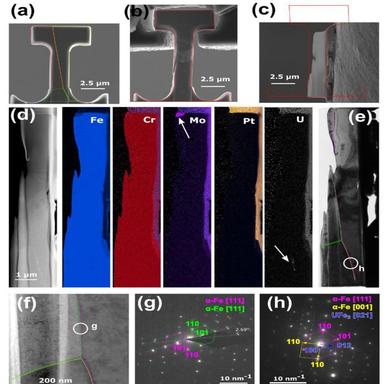
TEM characterization on the post-tested HT9_005 specimen. (a) A SEM image captured before testing with identified grains outlined; (b) a post-test SEM image; (c) a SEM image of the prepared TEM foil extracted from gage area in (b). (d) STEM high-angle annular dark-field (HADDF) image and the STEM-EDS characterization result. (e) STEM bright field (BF) image with the identified grain boundary outlined. (g) and (h) Diffraction patterns of the selected area as a white circle highlighted in the STEM BF image (f